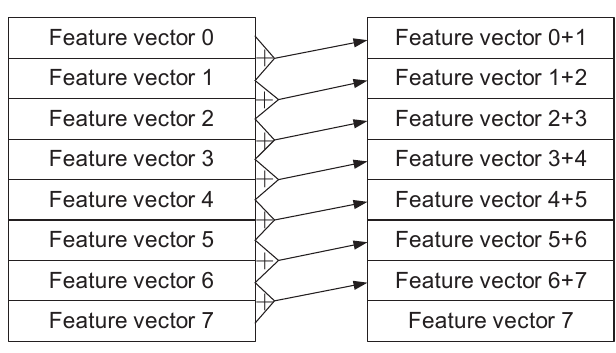
Figure 25. Pre-add for redundant computations